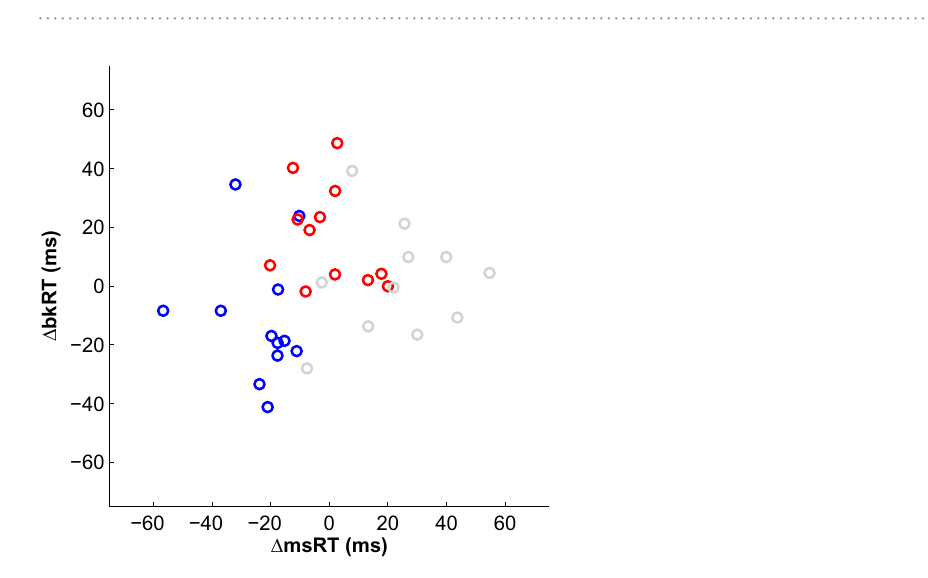
Figure 5. The effect of morphological structure on blink inhibition. Mean blink RT (bkRT; the latency of the first blink following stimulus onset) is averaged across trials and then across subjects, for each condition. N = 12 after excluding 4 subjects due to low blink rate ( < 10% of trials). Only trials that had a blink in the specified time window (200–900 ms) were included in the calculation (24% of trials in each condition on average). Data were normalized (de-meaned) per subject, averaged across subjects and adjusted by adding the group grand-average (see Methods). Error bars denote standard error across all subjects. As shown, blinks in Real-root trials were significantly delayed by 27 ms on average, compared to Invented-root trials (nonparametric permutation test). * p < 0.001.